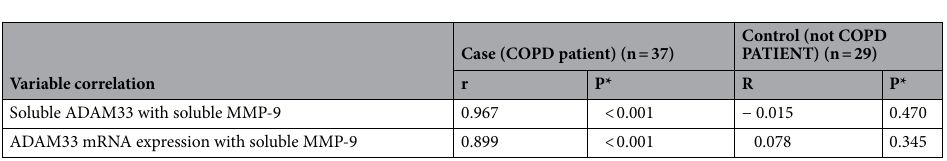
Table 5. Correlation of ADAM33 Soluble Levels and ADAM33 mRNA expression with MMP-9 in COPD patients and non-COPD patients. *Spearman correlation.